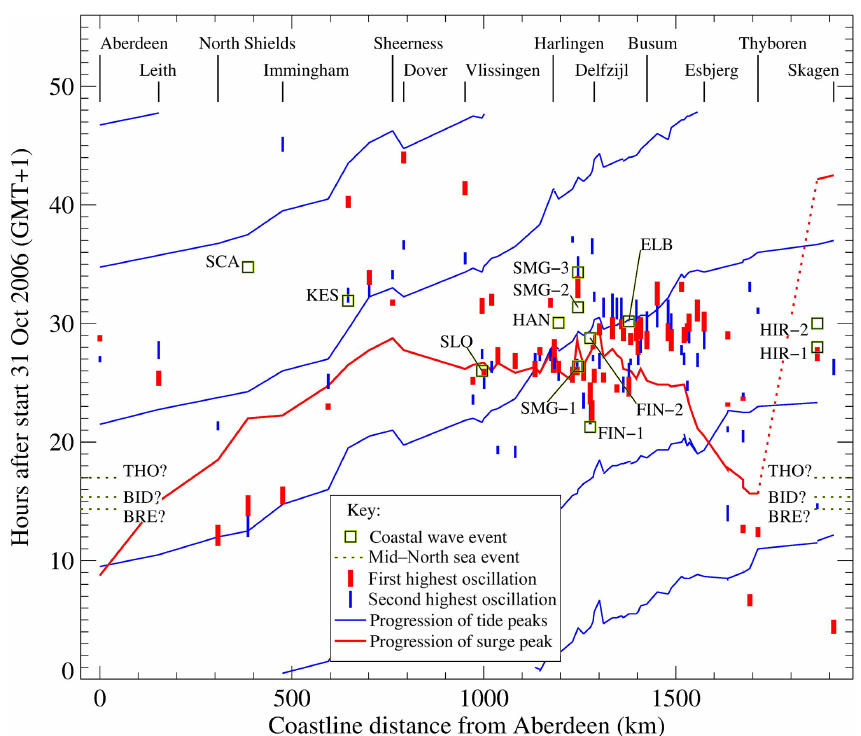
Figure 4. Relation between time and coastline distance around the North Sea for the semi-diurnal tide peaks, storm surge peaks, large wave events, and the two highest amplitude oscillations from the short period time series reconstructions for each tide gauge station in Fig. 2d. The abbreviations for the wave events are given in Table S2. The vertical length of the bar for the short period oscillations denotes the zero-crossing period of the down-crossing oscillation; the width and colour of the bar are used to distinguish the first and second highest